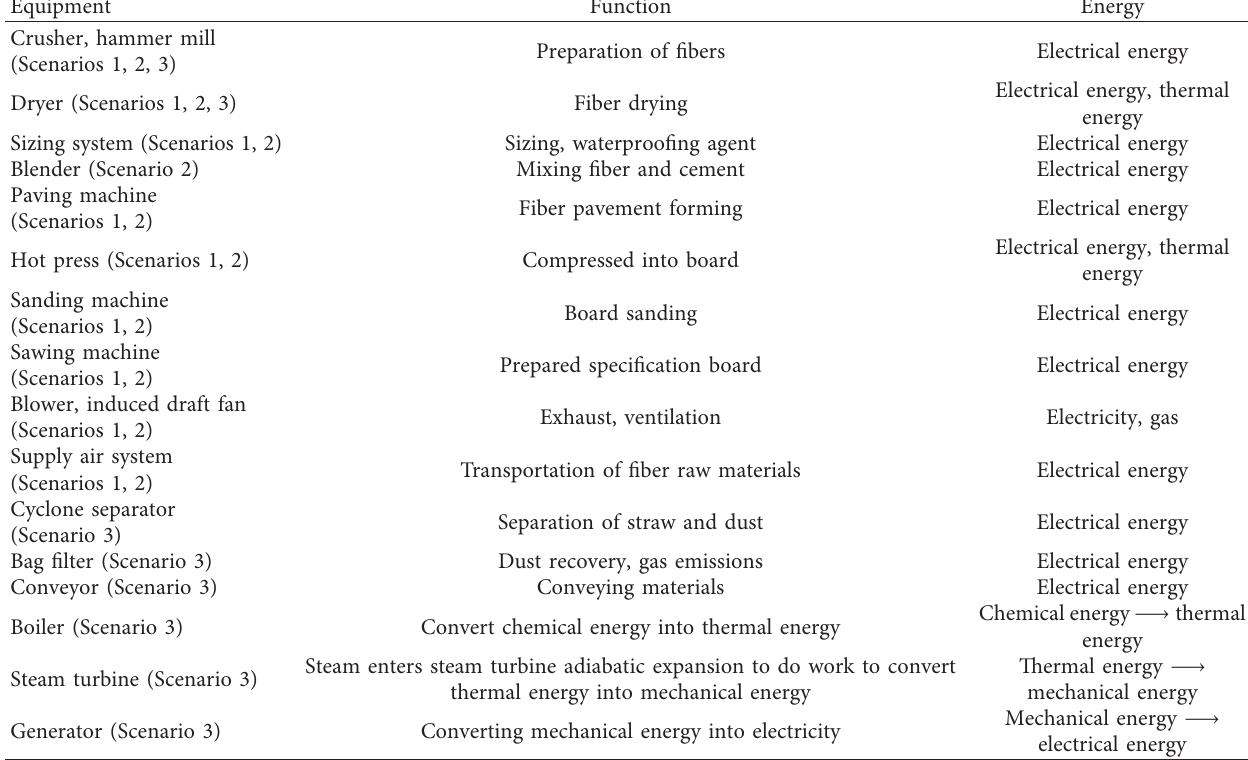
Table 3: Major equipment and energy used in the production process of Scenarios 1, 2, and 3.